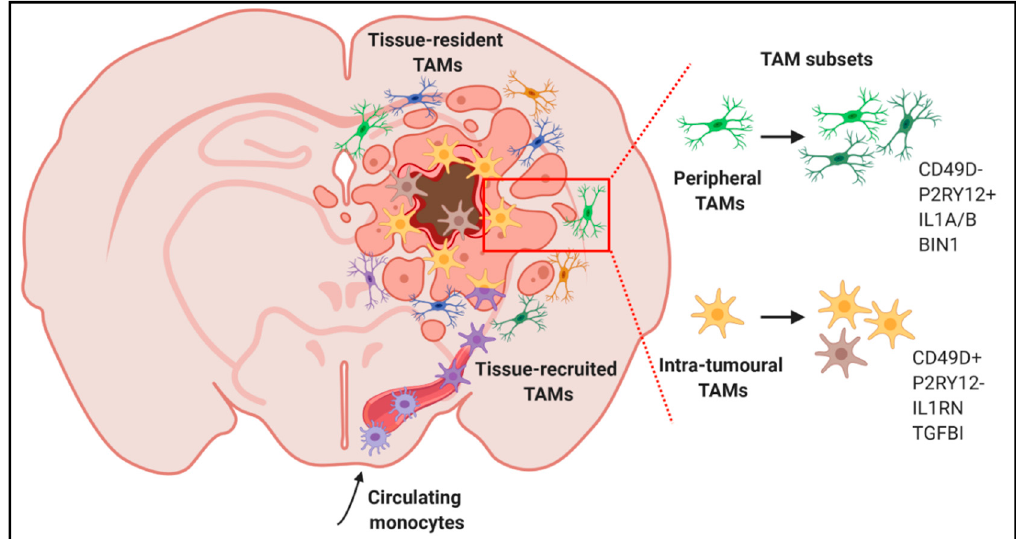
Figure 2. Discrimination of specific TAM subpopulations in GBM patients. TAMs present distinct features according to their ontogeny and spatial localization in specific tumour areas.